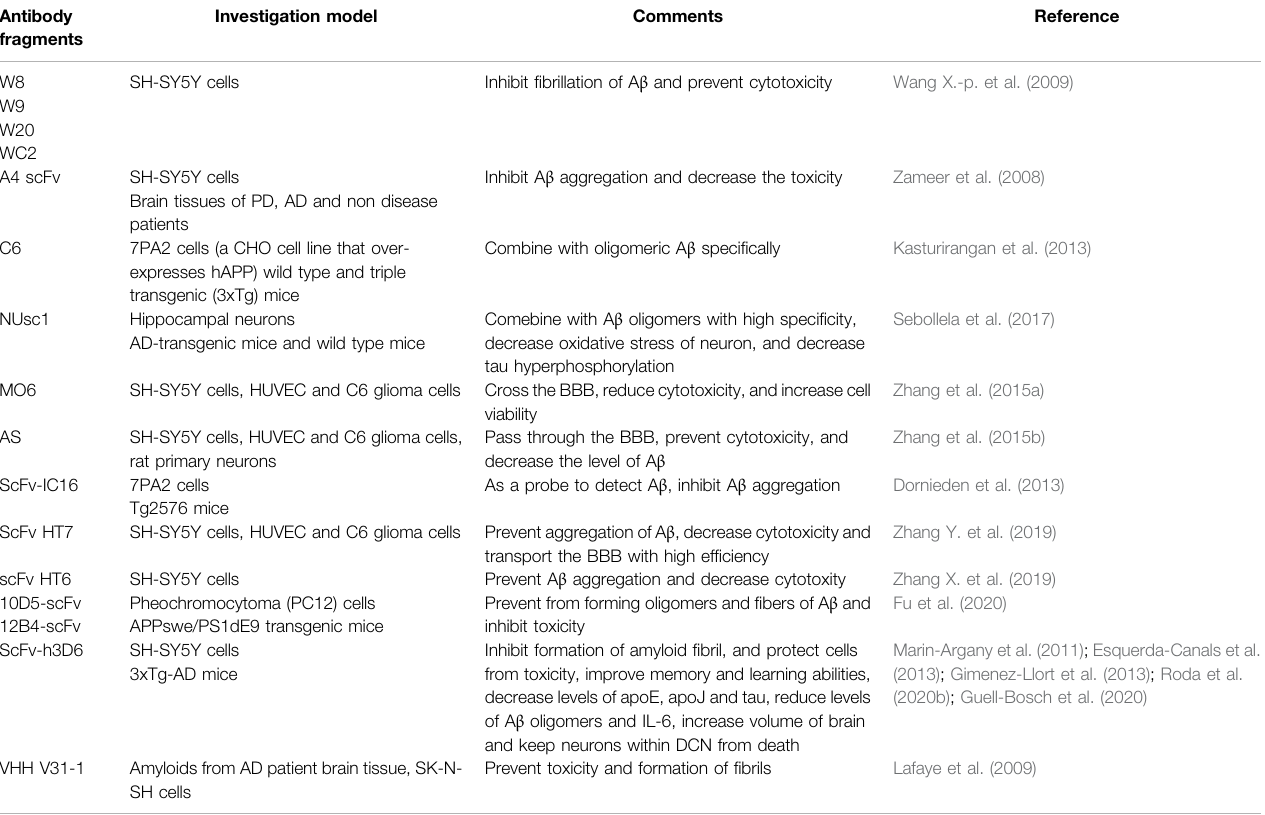
TABLE 2 | Antibody fragments against A β